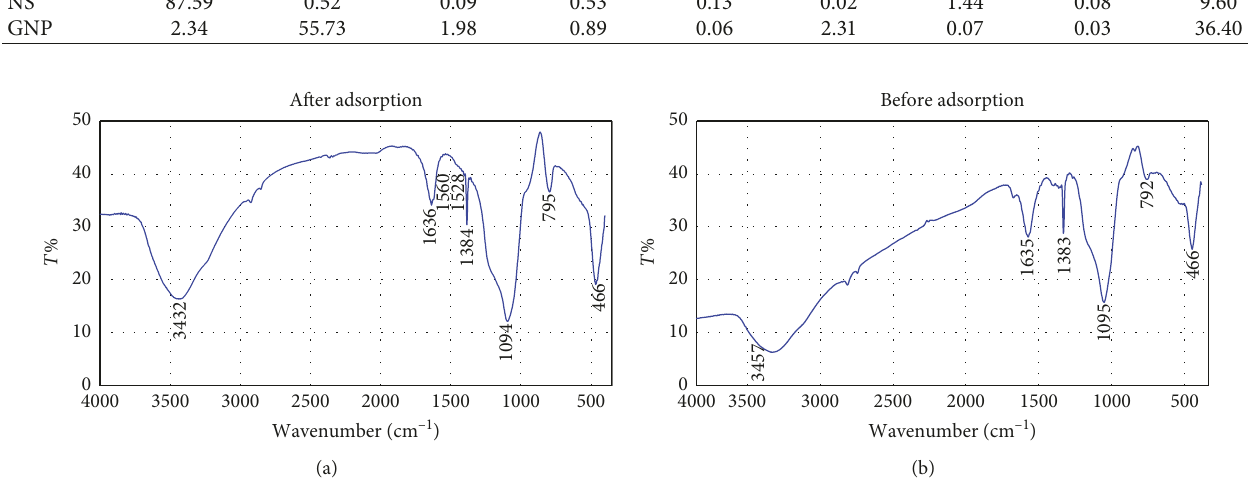
Figure 2: FTIR spectra of the NSG nanocomposite: (a) after adsorption and (b) before adsorption.